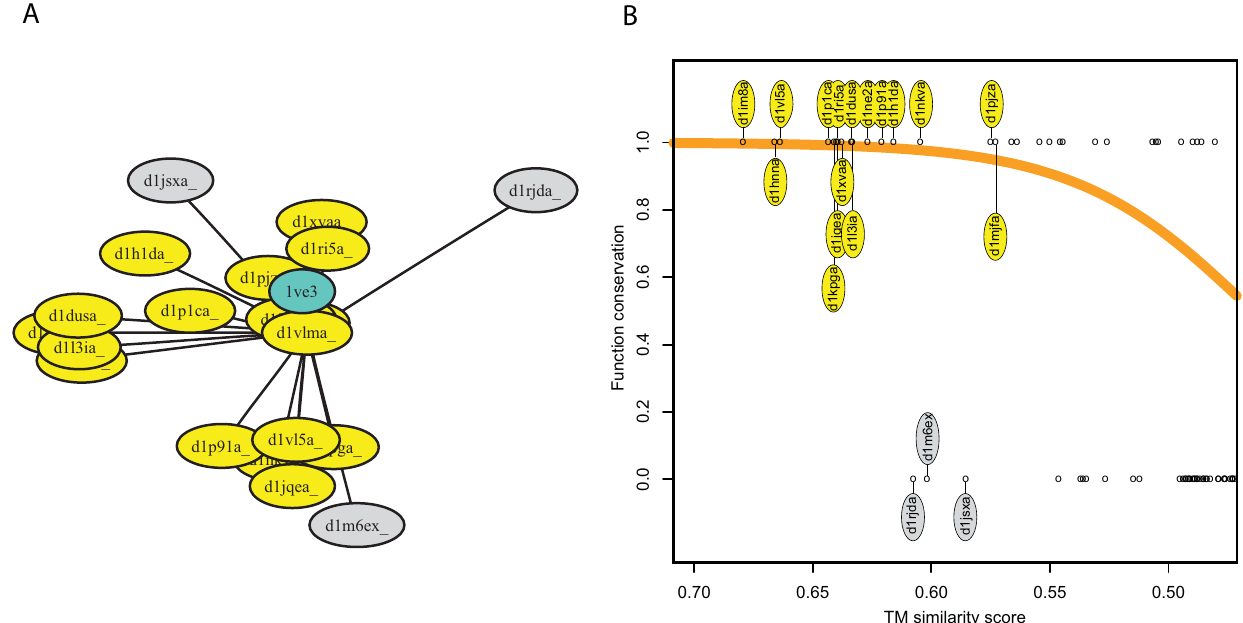
Figure 4. Sample Neighborhood. (A) Using TM to identify the nearest neighbor of the sample query protein 1ve3 yields protein domain d1vlma. For d1vlma the TM scores were pre-computed, resulting in the neighborhood illustrated here with Kruskal’s non-metric multidimensional scaling [44](where similar proteins structures are depicted close). Domain d1vlma has several molecular functions attached, for this illustration we selected GO:0008757 (S-adenosylmethionine-dependent methyltransferase activity). Protein domains having this function are colored yellow, domains not annotated with this function are colored in grey. (B) TM scores with respect to d1vlma are sorted along the x-axis. Protein domains annotated with molecular function GO:0008757 are assigned a y coordinate of 1 (drawn in yellow), domains not annotated with this function are assigned a y coordinate of 0 (drawn in grey). Unlabeled domains are from the 200 nearest neighbors of d1vlma. A logistic curve is fit through these points (drawn in orange). The logistic curve can be evaluated for the raw function conservation score for a given TM score.